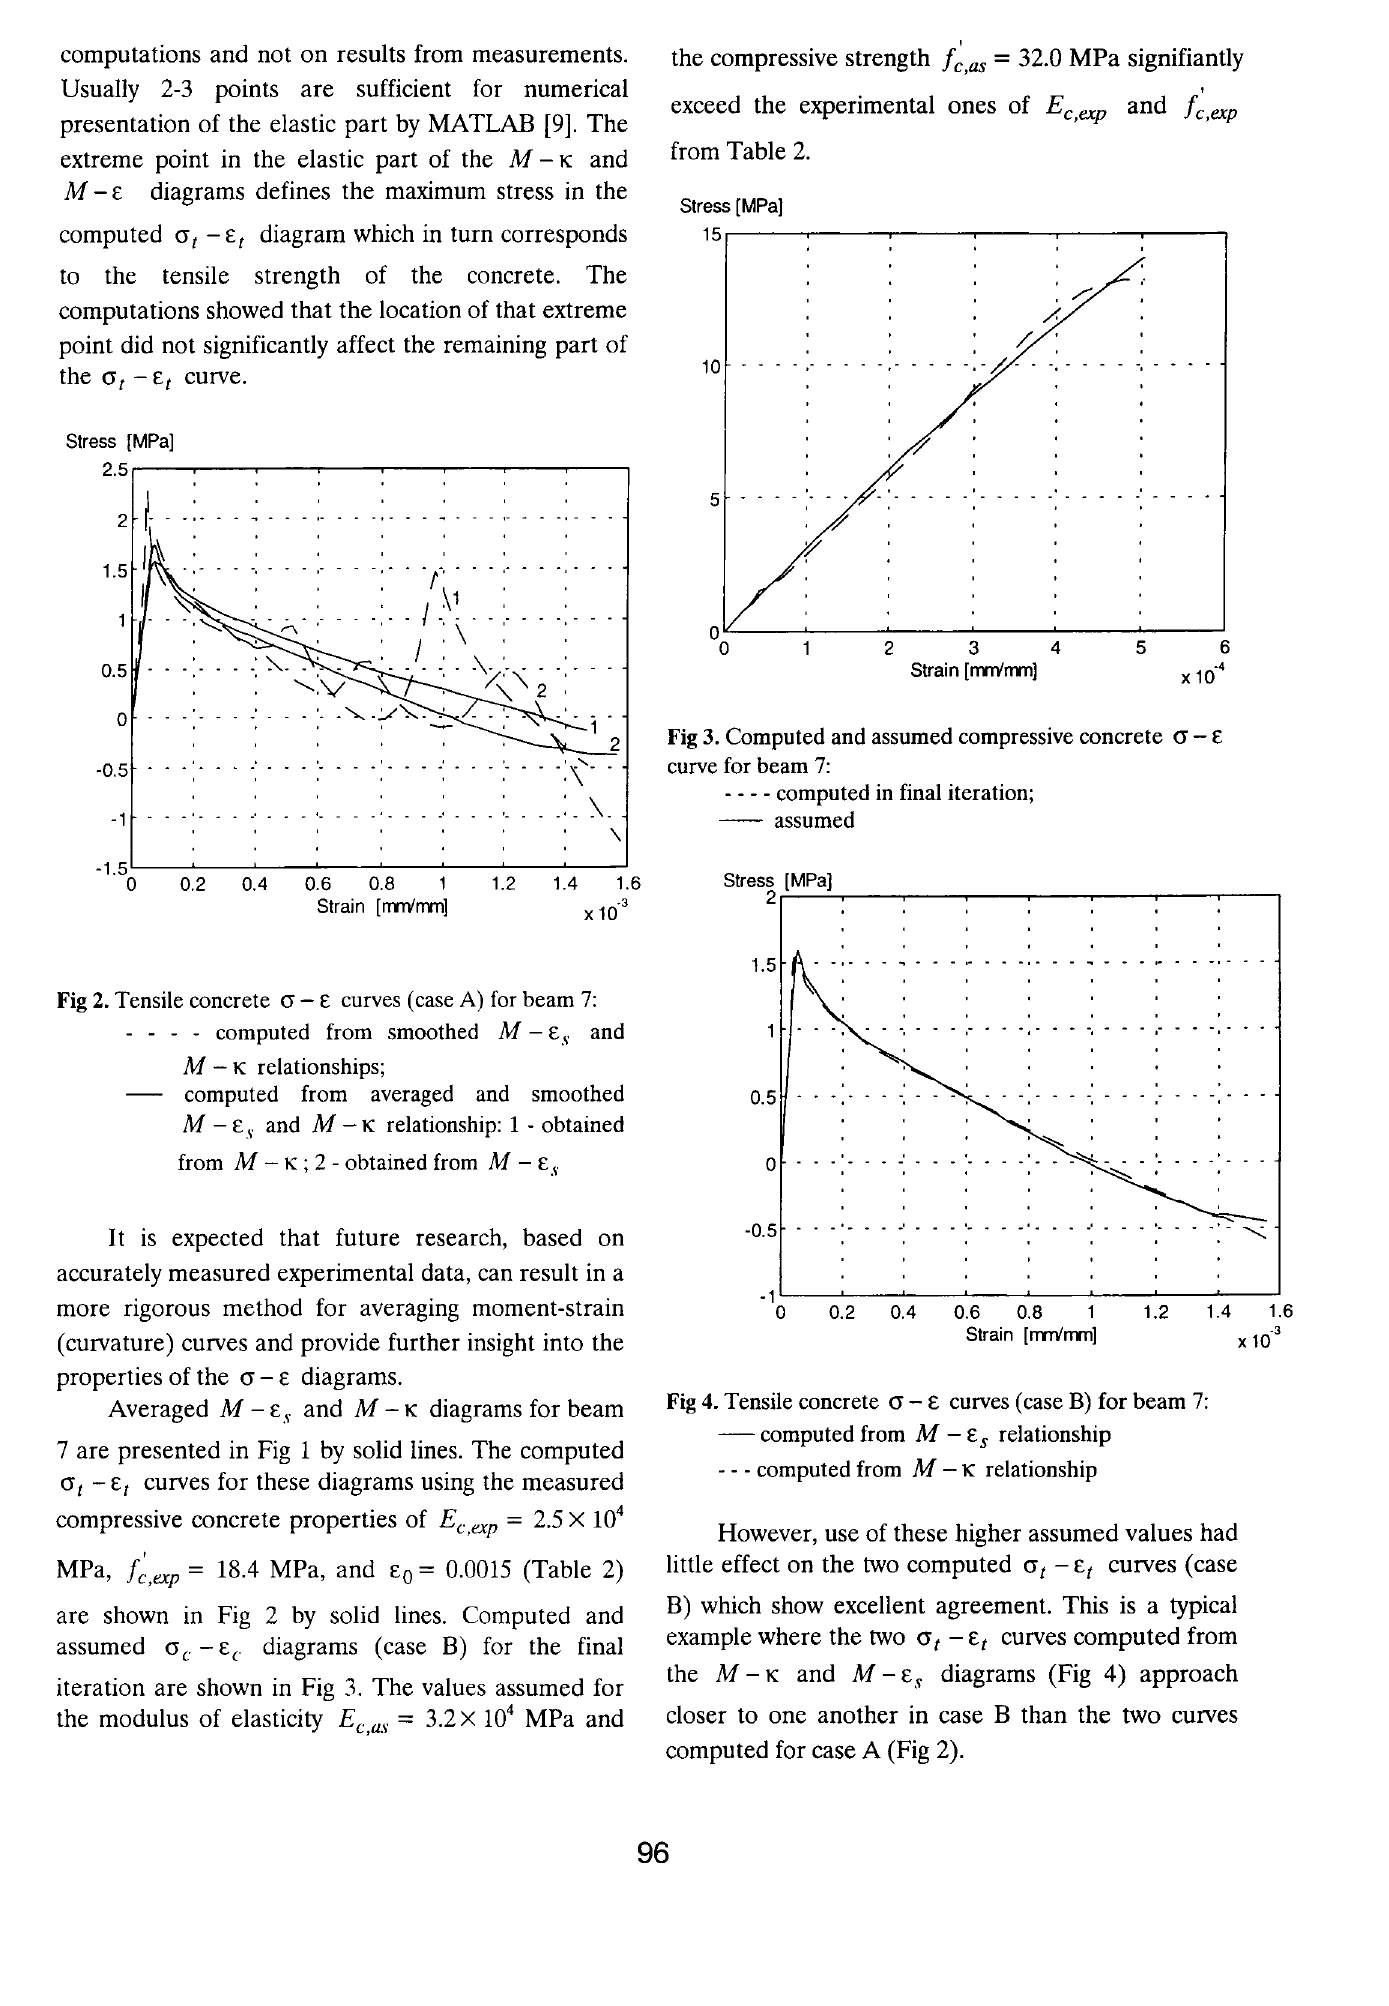
Fig 4. Tensile concrete cr- E curves (case B) for beam 7: - computed from M - E s relationship - - - computed from M - K relationship However, use of these higher assumed values had curves (case little effect on the two computed cr 1 - E1 B) which show excellent agreement. This is a typical example where the two cr curves computed from 1 - E1 the M - K and M - £ s diagrams (Fig 4) approach closer to one another in case B than the two curves computed for case A (Fig